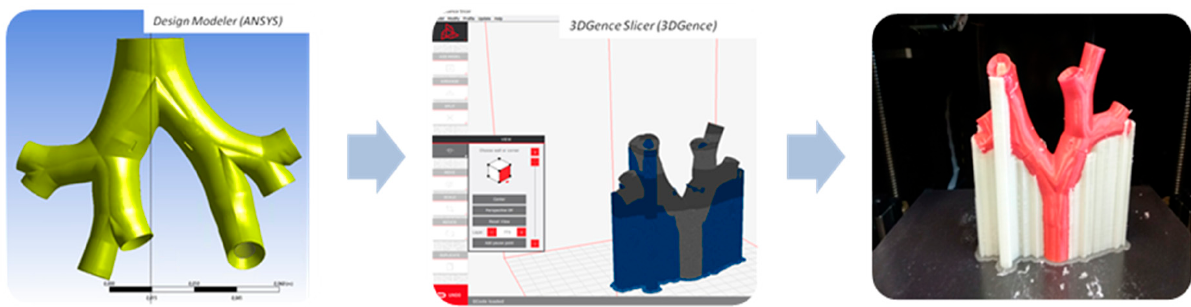
Figure 1. Consecutive steps of model respiratory tract preparation.